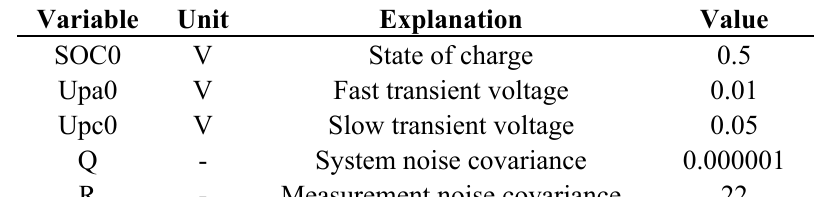
Table 4. Preset initial values of the estimation algorithm.